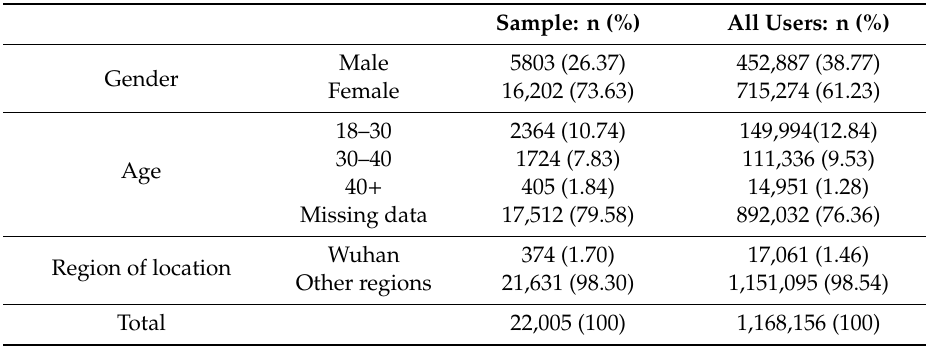
Table 1. Demographic characteristics of selected